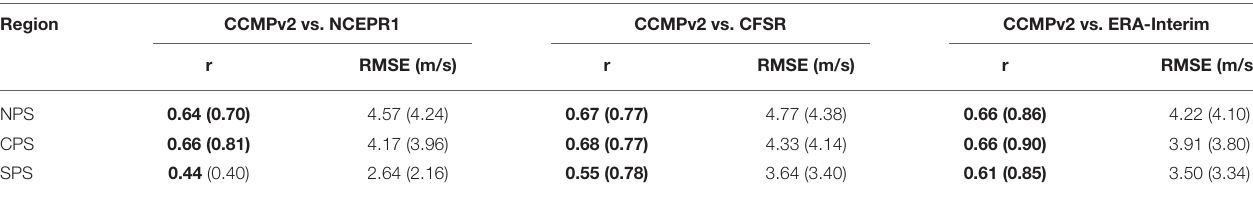
TABLE 4 | Linear correlation coefficients (r) and root-mean-square error (RMSE) of 10 m wind speed derived from CCMPv2 and from reanalysis NCEPR1, CFSR and ERA-Interim at NPS, CPS and SPS. Region CCMPv2 vs. NCEPR1 CCMPv2 vs. CFSR CCMPv2 vs.